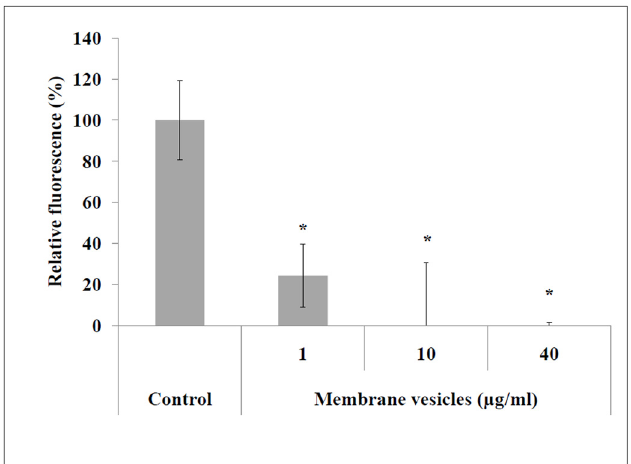
Fig 4. Quantification of NET degradation by S . suis membrane vesicles. NETs were formed by the PMA- stimulated promyelocytic leukemia cell line HL60. * : p < 0.05 compared to the negative control (no NET